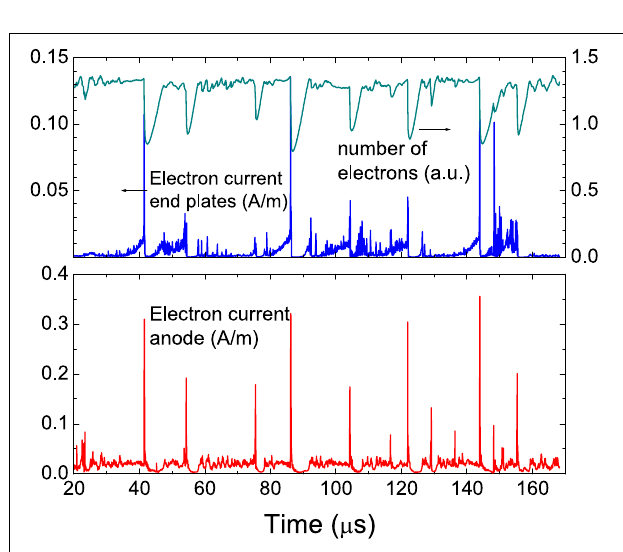
FIGURE 4 | Left: particular sequence in the evolution of electron vortices in the conditions of Figure 3 ; Right: number of electrons as a function of time in the sequence (each time of the left plot is indicated by a